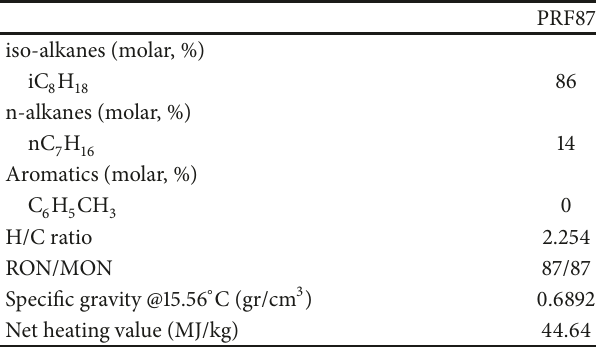
Table 9: Composition and properties of PRF